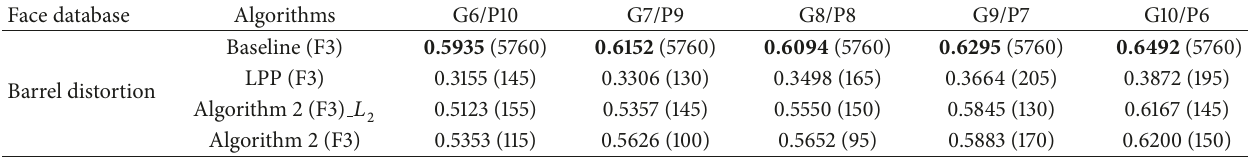
Table 24: The recognition rates on barrel distortion Extended Yale B face database over “F3” features; recognition rates (dimensionality).